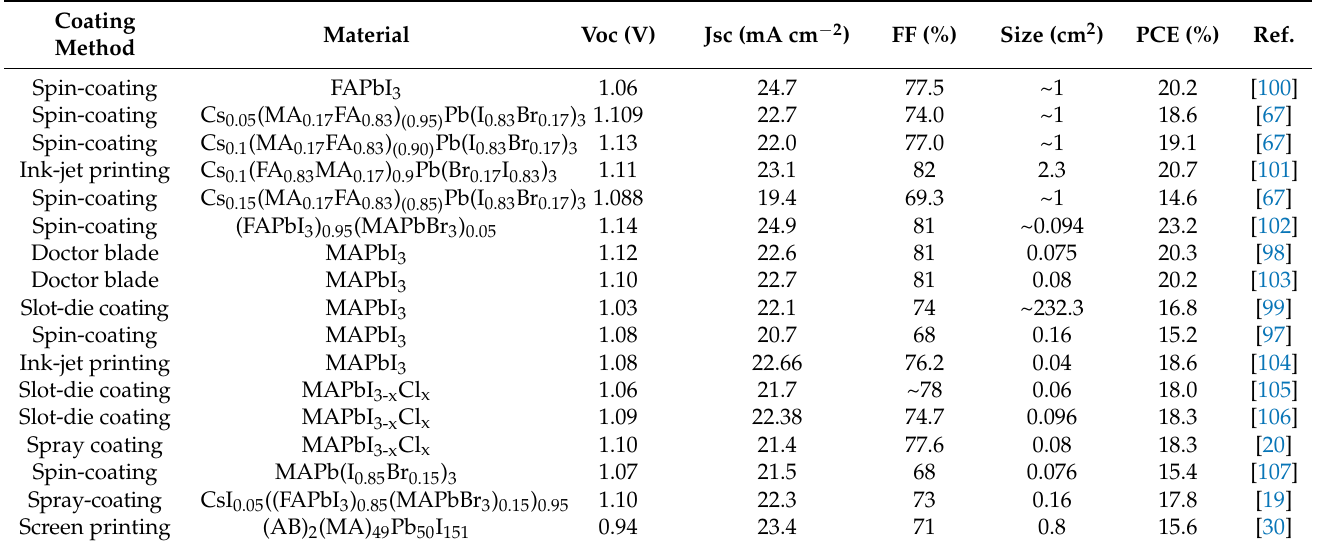
Table 1. Various materials and methods for HOIP PV fabrications. Voc, Jsc, and FF are open-circuit voltage, short-circuit current density, and fill factor,